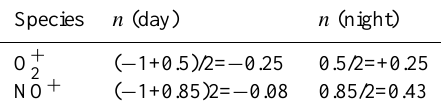
Table 1. How electron density depends on temperature, T n for dif- ferent primary positive ion species and day and night